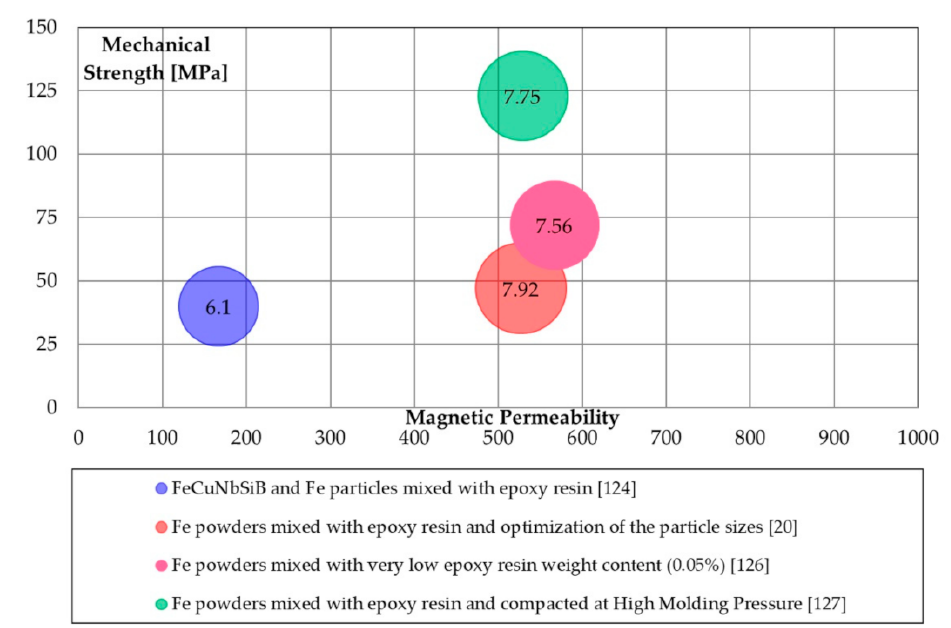
Figure 7. Magnetic (maximum permeability), mechanical (TRS [MPa]), and energetic properties (total iron losses 1 T@50 Hz [W/kg]) of epoxy coating